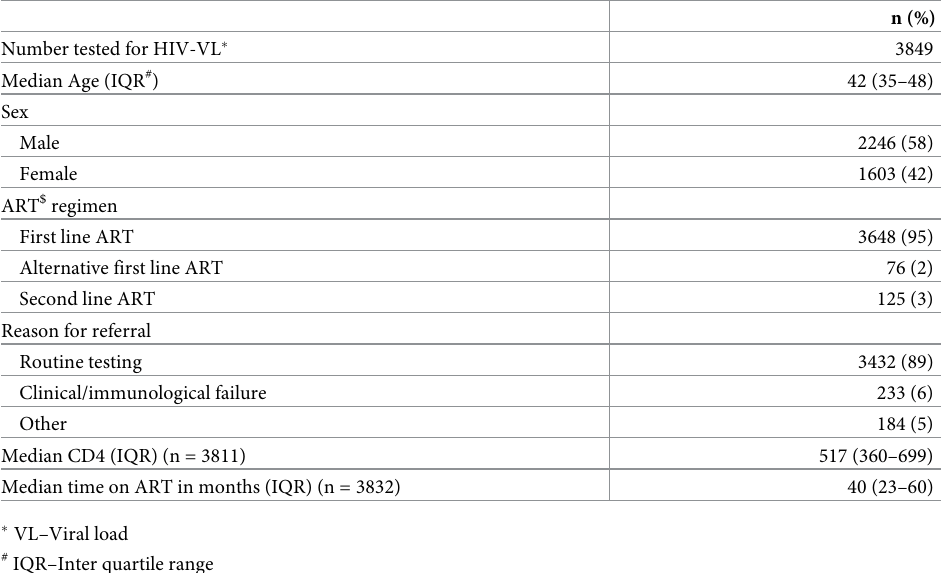
Table 2. Socio-demographic and clinical characteristics of PLHA tested for HIV viral load at ART centre, KEM hospital, Mumbai during October 2016 –September